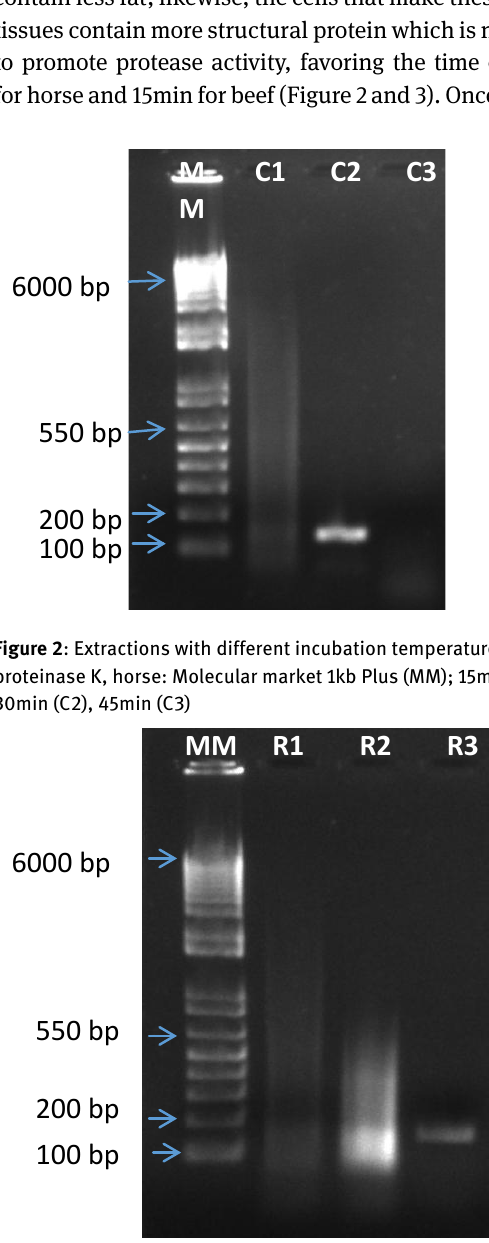
Figure 4: PCR meat products. Molecular market 1kb Plus (M); nega- tive control with beef (1), the positive control on horseback (2), and lane 3 to 9 different processed